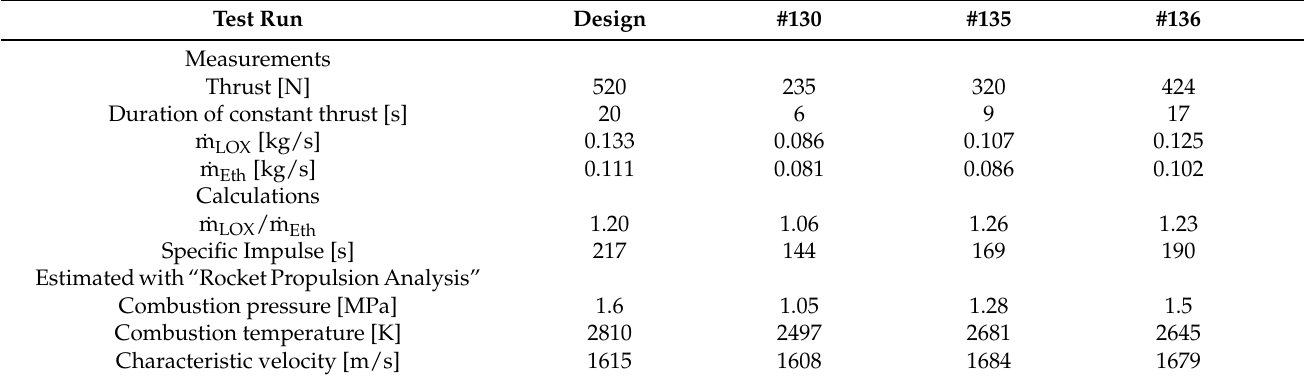
Table 5. Measured and calculated engine data in comparison to design